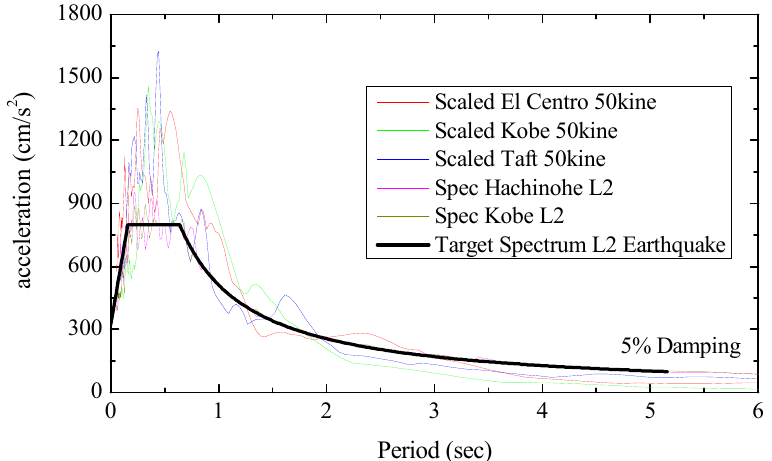
Figure 6. Response acceleration spectrum of selected ground motions (5% damping). Table 3. List of selected earthquake ground motions.